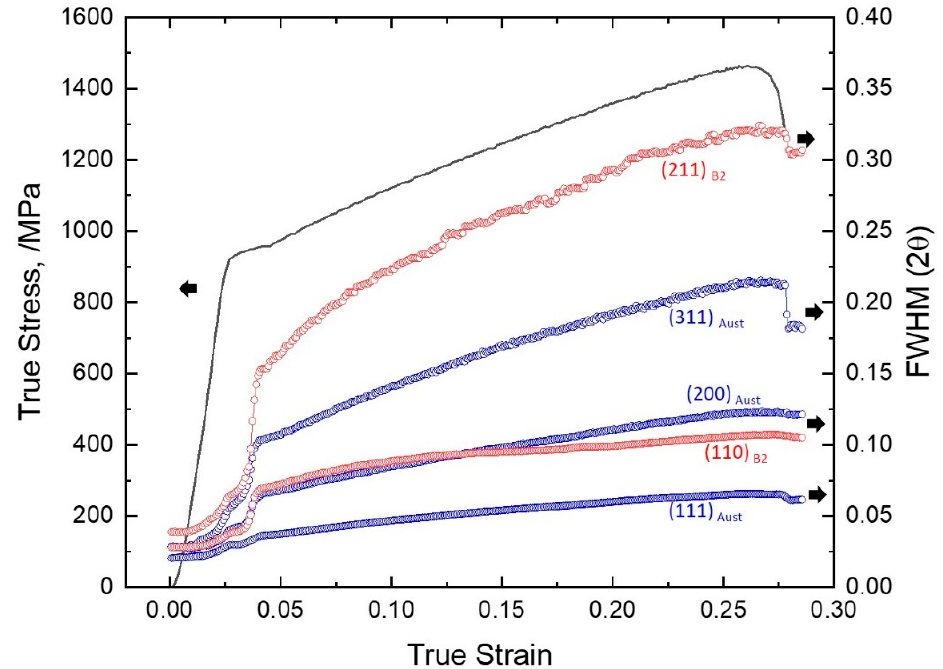
Figure 10. The full width at half maximum (FWHM) of the diffraction peaks of austenite and B2 phase are plotted as a function of the tensile true strain. The global true stress-strain curve is also superimposed.